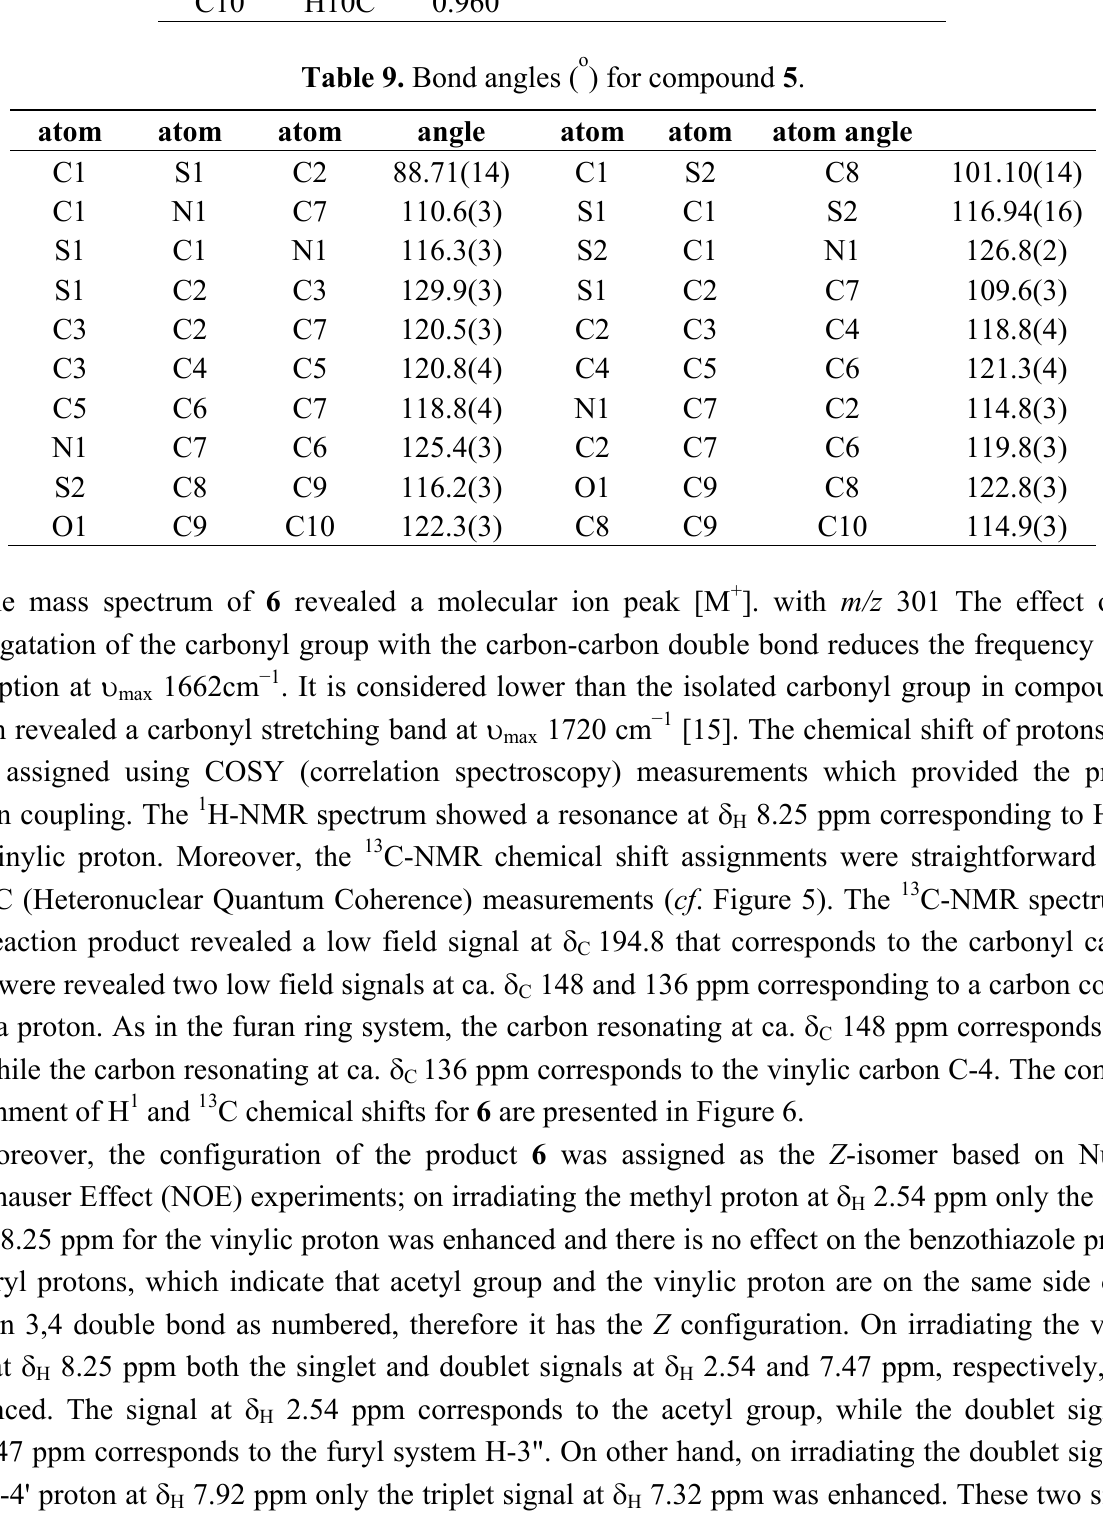
Table 9. Bond angles (